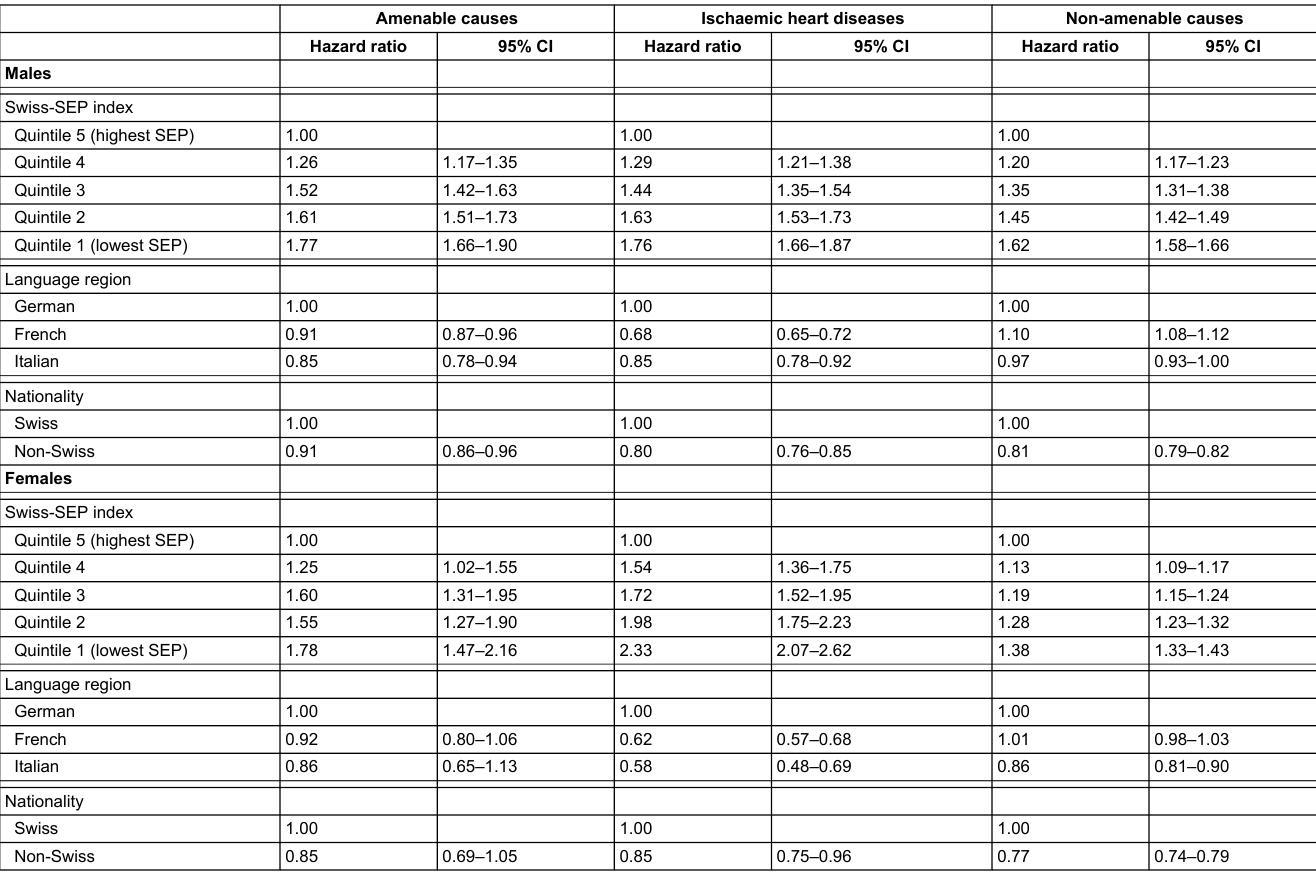
Table 4: Hazard ratios of deaths and 95% confidence intervals (95% CI), age 0–74 years: amenable causes, ischaemic heart diseases and non-amenable causes by sex for the population of Switzerland at census 2000, followed until death, migration or the end of